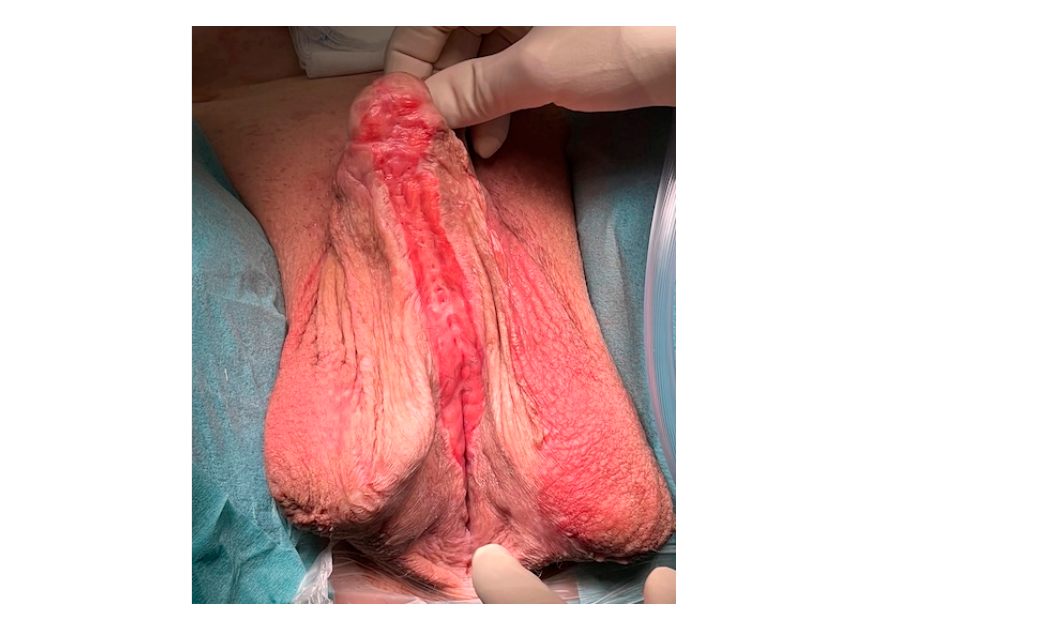
Figure 9. Closure of the neourethra with inverted running sutures. The laterally fixed scrotal skin during the first procedure is dissected again, and the normal anatomy is reconstructed by approximating the two scrotal skin halves in the mid- line to reproduce a raphe (Figure 10).